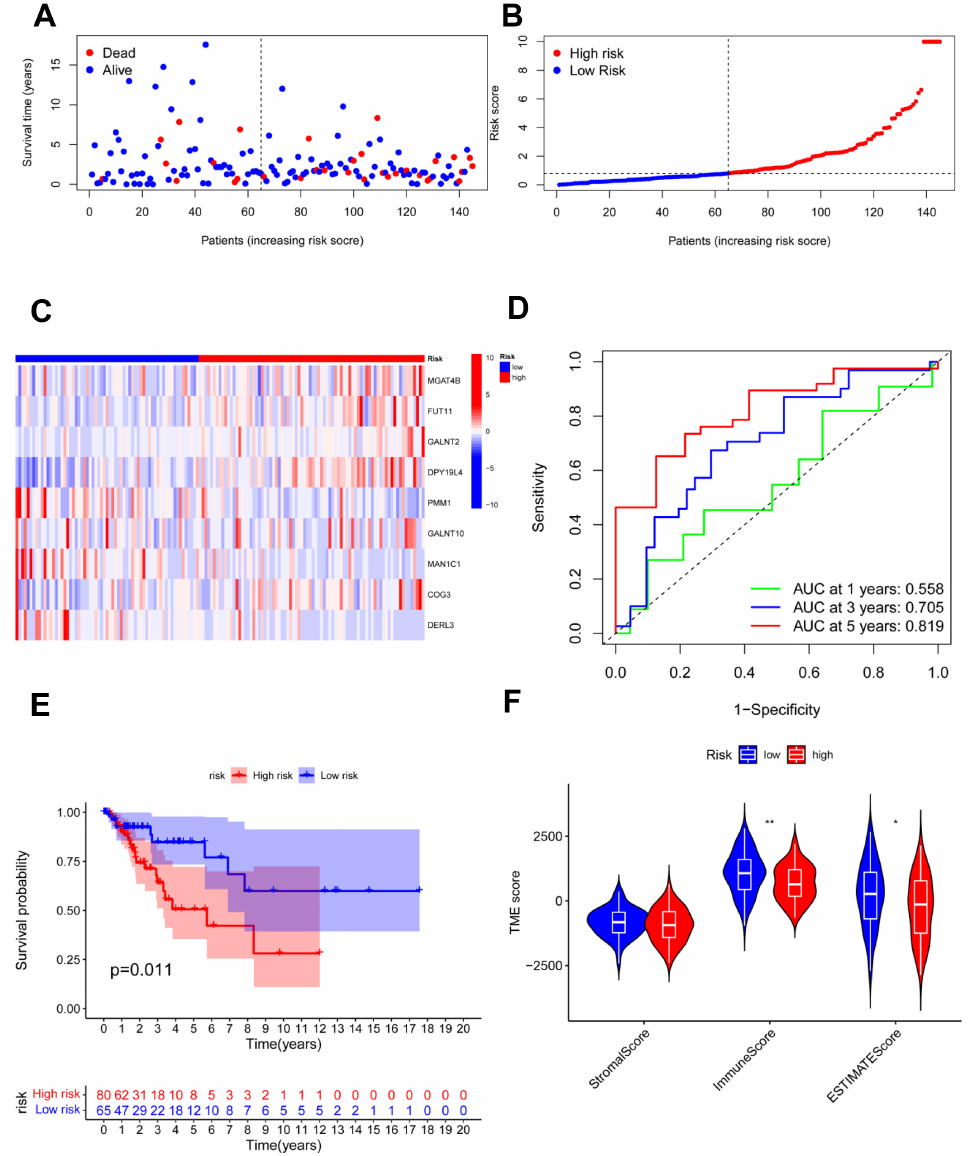
Figure 5. Validation of the risk model in the testing cohort. ( A – B ) Assessments of the survival status and risk scores in the two groups; ( C ) the risk gene expression in the testing cohort; ( D ) ROC curve of the risk model; ( E ) survival curves in the two groups; ( F ) stromal, immune, and ESTIMATE scores of the two groups. * p < 0.05; ** p < 0.01.